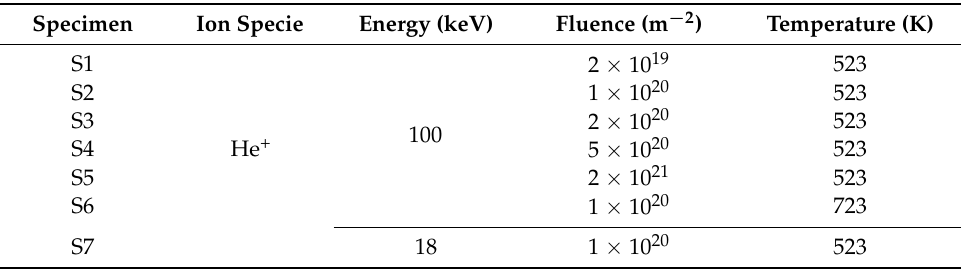
Table 2. Irradiation conditions in present